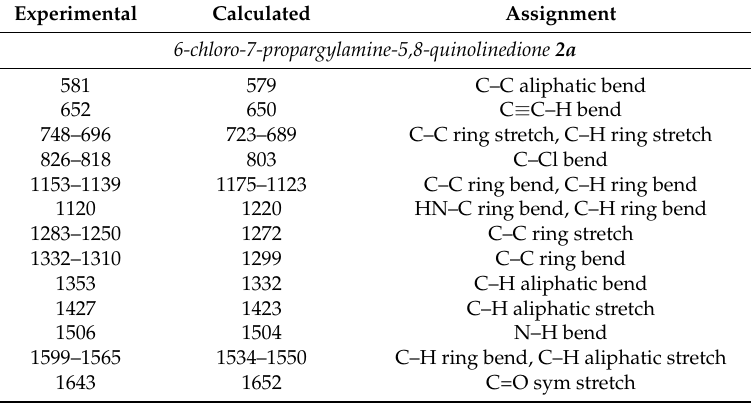
Figure 5. Experimental (red line) and calculated (black line) IR spectra for 7-chloro-6-propargylamine- 5,8-quinolinedione 3a (450–3500) cm − 1 . See Table 3 for band assignments. Table 3. Experimental and calculated vibrational frequencies (cm − 1 ) and band assignments for studied compounds 2a and 3a . Experimental Calculated